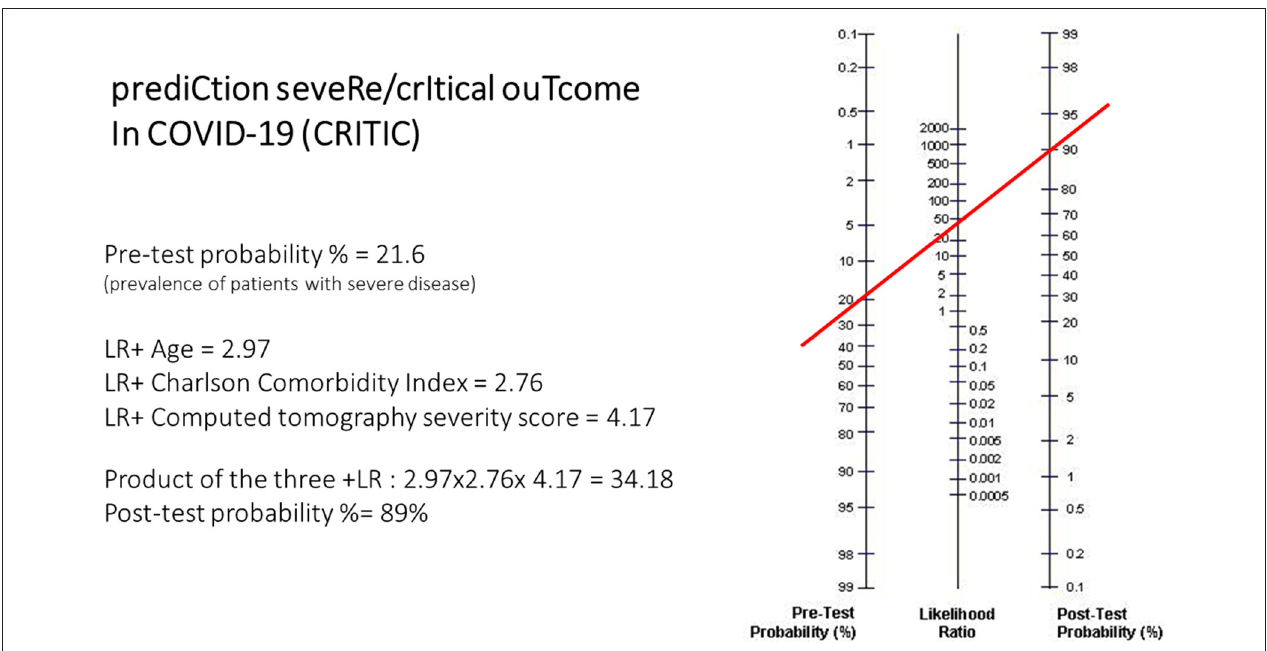
FIGURE 2 | Example of application of the nomogram in the calculation of the CRITIC post-test probability. In the nomogram left axis represents the pre-test probability (21.6% in this case study), middle axis represents positive likelihood ratio, and the right axis shows post-test probability. To calculate the actual risk (post-test probability, %) of severe/critical disease in a given patient with COVID-19 pneumonia, the positive likelihood ratio of each item in that patient have to be multiplied. The resulting positive likelihood ratio product represents the point intercepted on the middle axis.